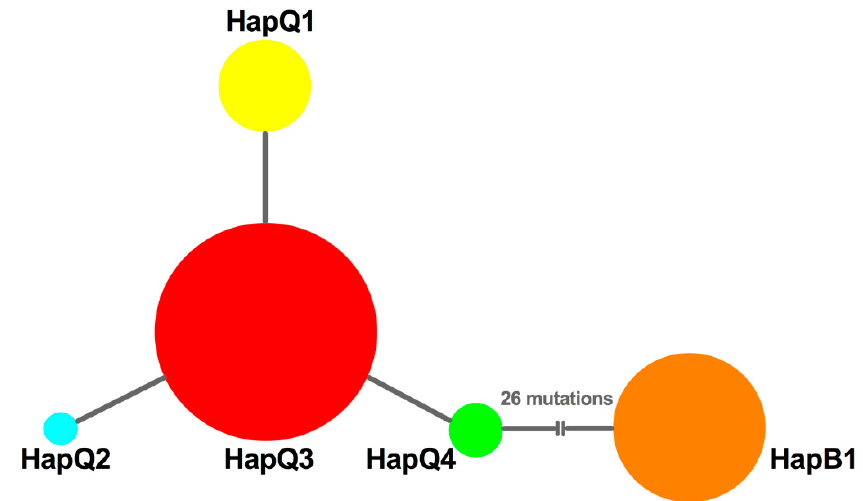
Figure 2. The network of haplotypes of B. tabaci . The sizes of circles are proportional to the number of individuals. HapQ1, HapQ2, HapQ3, and HapQ4 are haplotypes of MED. HapB1 is a haplotype of MEAM1.